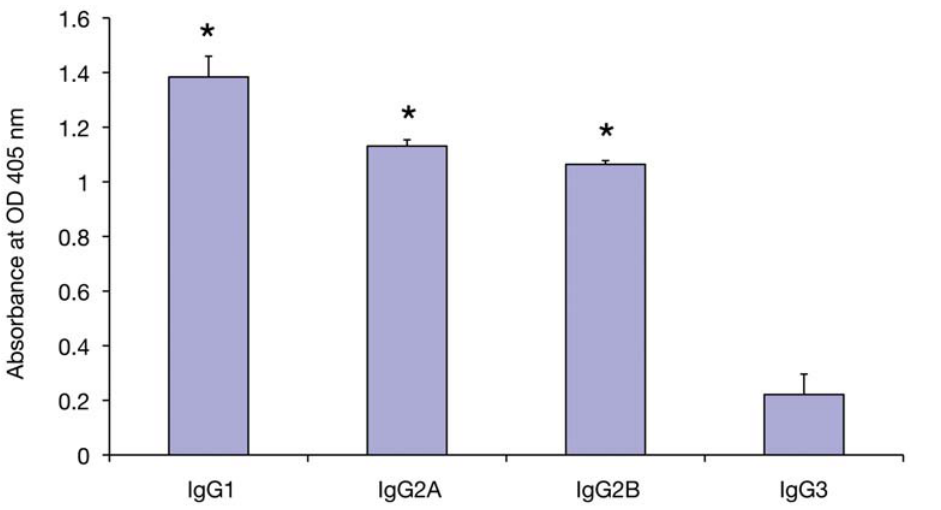
Figure 4. Subclass specific anti-WbGST IgG antibodies in the sera of mice immunized with rWbGST protein. Subclass analysis was performed using a mouse antibody isotyping ELISA kit. The bars represent the mean O.D. 6 SD at 405 nm of five mice per group.